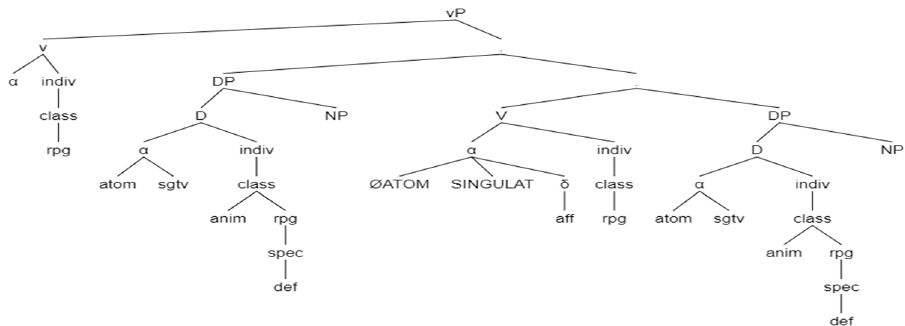
Figure 14. Geometry of the step 3 and the step 4.